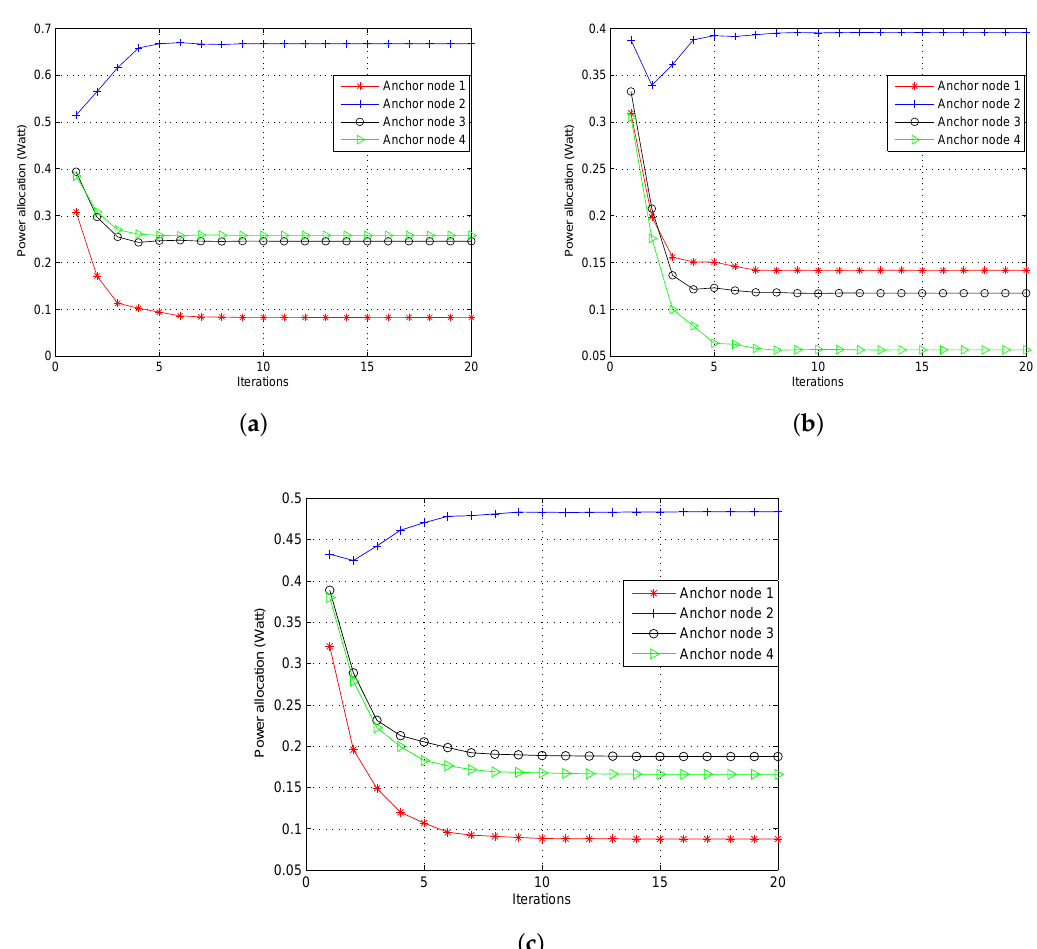
Figure 3. Convergence for power allocation in different cases. ( a ) Case 1; ( b ) Case 2; ( c ) Case